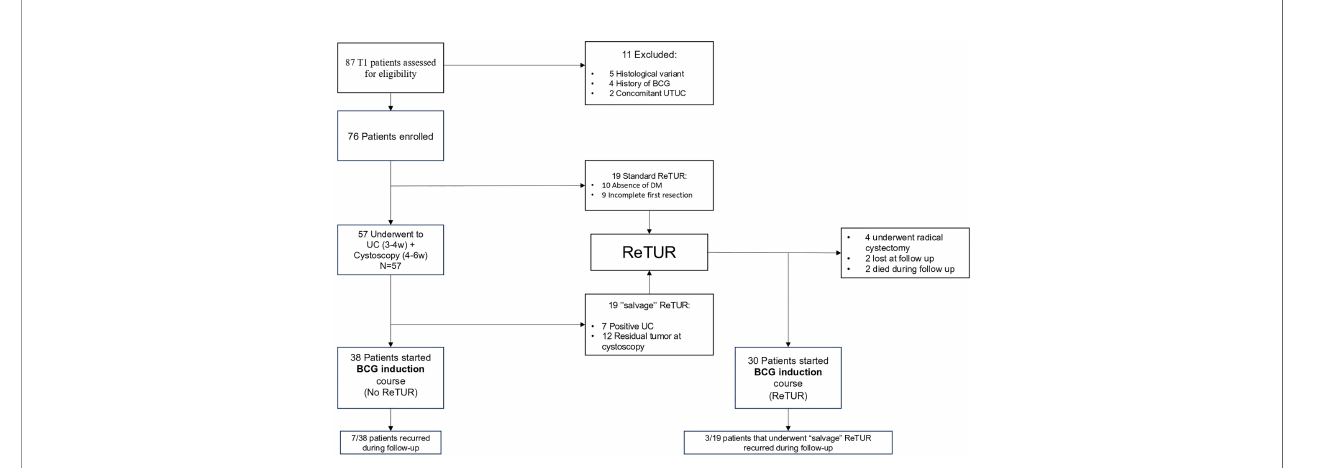
FIGURE 1 | Flow of patients through the study. NMIBC, Non-Muscle Invasive Bladder Cancer; MIBC, Muscle Invasive Bladder Cancer; DM, Detrusor Muscle; UC, Urine cytology; UTUC, Upper urinary tract urothelial cancer.